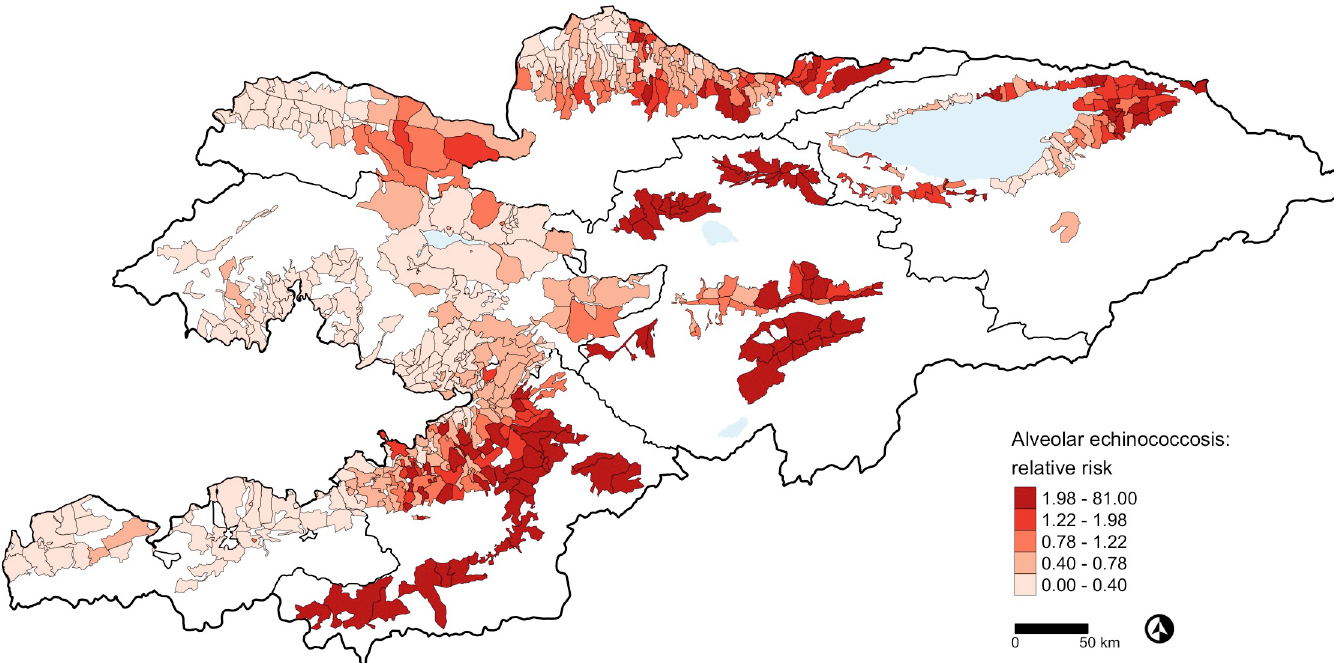
Fig 2. Estimated relative risk based on the Besag, York and Mollie´ model for alveolar echinococcosis in Kyrgyzstan, 2014-2016. The local administrative units of Kyrgyzstan cover only the settlements and their surroundings. The white spaces are unsettled areas that do not fall within any local administrative unit. We used the third level administrative boundaries of Kyrgyzstan as provided by REACH, a joint initiative of IMPACT, ACTED, and the UN Operational Satellite Applications Programme (UNOSAT) under a humanitarian license. The shapefiles were subsequently edited to add missing polygons. The code and files for the map are available at: https://git. math.uzh.ch/reinhard.furrer/Echin_kgz. Shape files for third level administrative regions are now freely available from the United Nations Office for the Coordination of Humanitarian Affairs https://data.humdata.org/dataset/kyrgyzstan-administrative-boundaries.